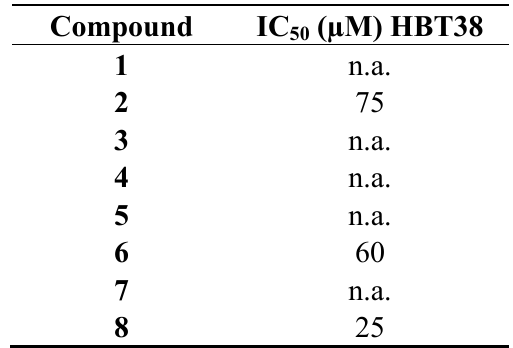
Table 1. Anti-proliferative activity: n.a. not